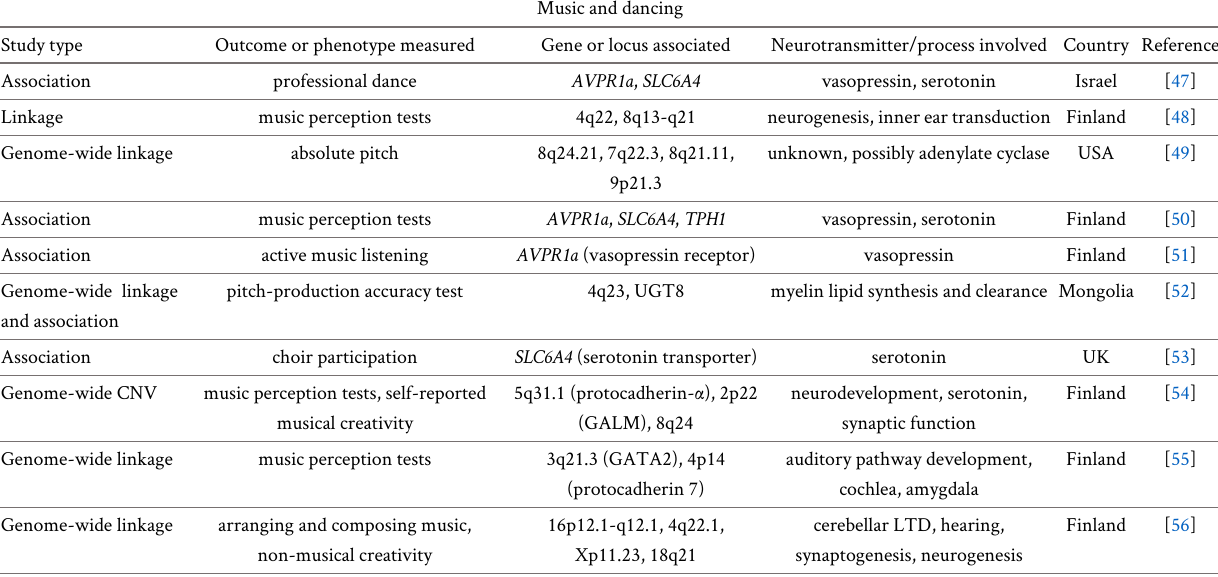
Table 2. Summary of published studies examining the genetic background of musicality and